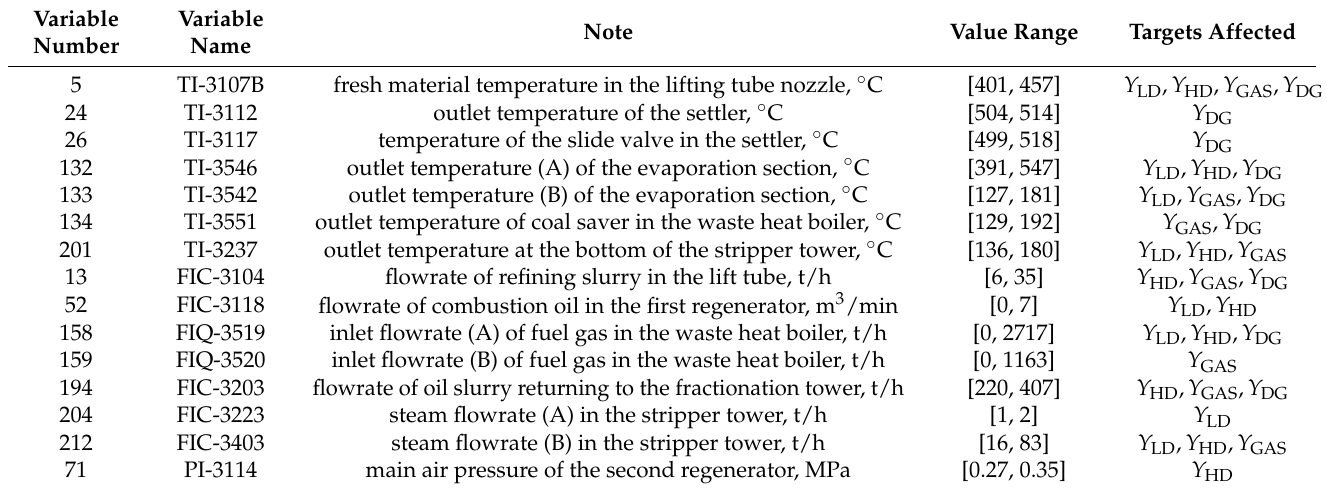
Table 4. Variables information related to the product yields of the process in Figure